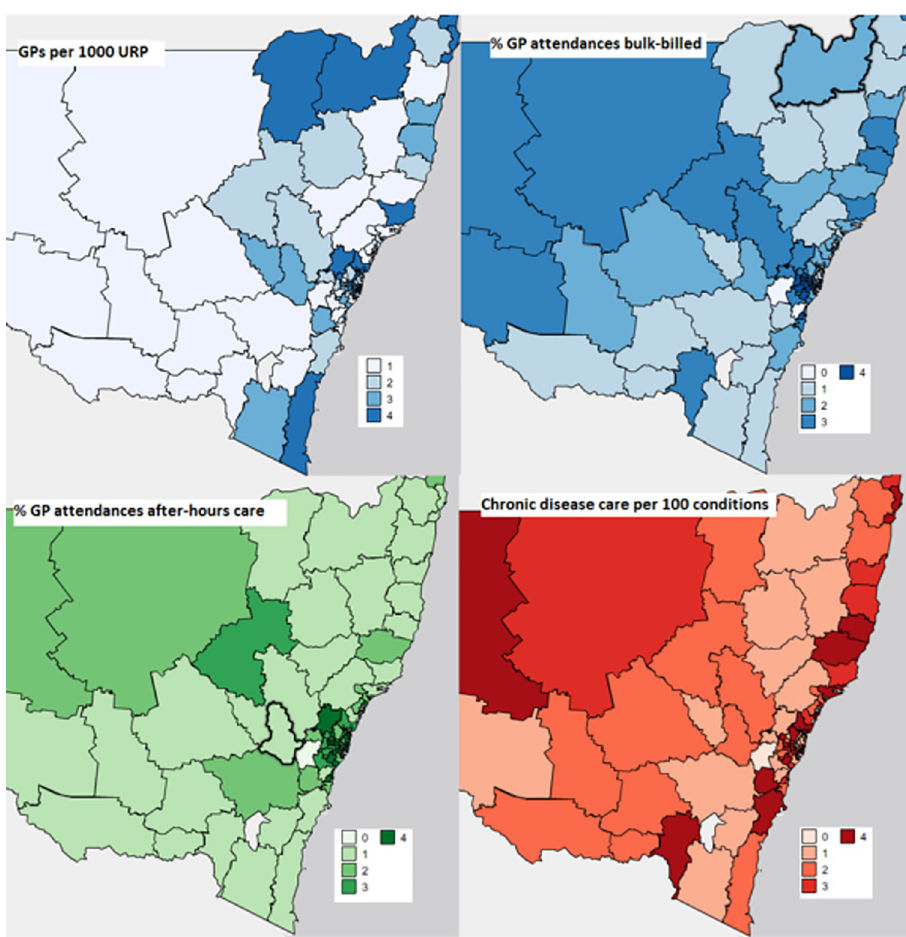
Fig 1. Geographical distribution of area PHC service characteristic quartiles from each domain and subdomain of PHC systems, by SA3. Abbrev. PHC, primary health care; SA3, Statistical Area Level 3; GP, general practitioner; URP, usual resident population; %, percent. Legend gives population-weighted quartile categories for each area PHC characteristic, where 1 is the first and lowest quartile and 4 is the fourth and highest quartile. Zero (0) refers to SA3s for which data were